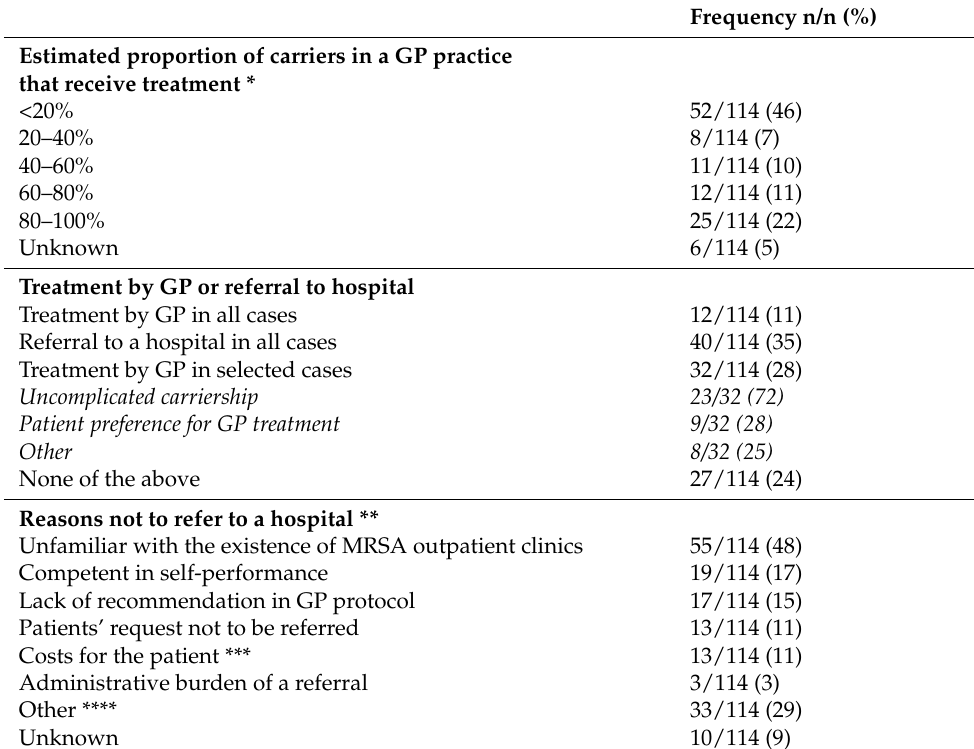
Table 2. Treatment of MRSA